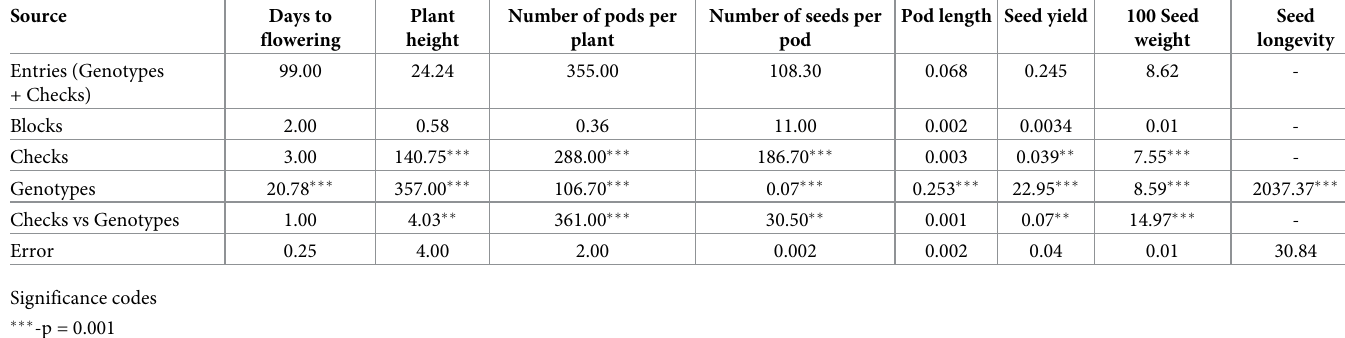
Table 4. Mean sum of square of genotypes and error for eight quantitative